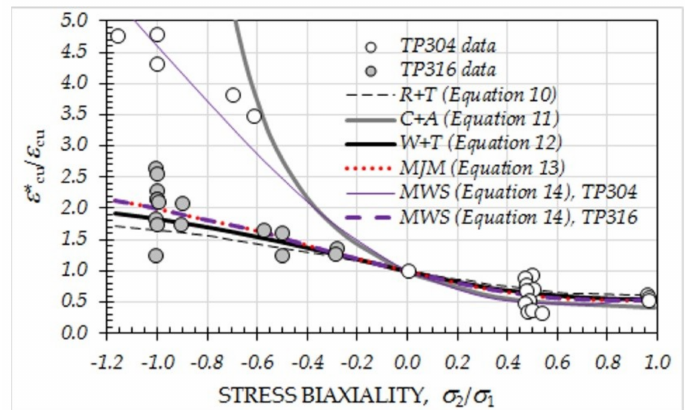
Figure 6. Comparison of multiaxial ductility model predictions with experimental observations for TP304 and TP316 stainless steels (data from [31]).